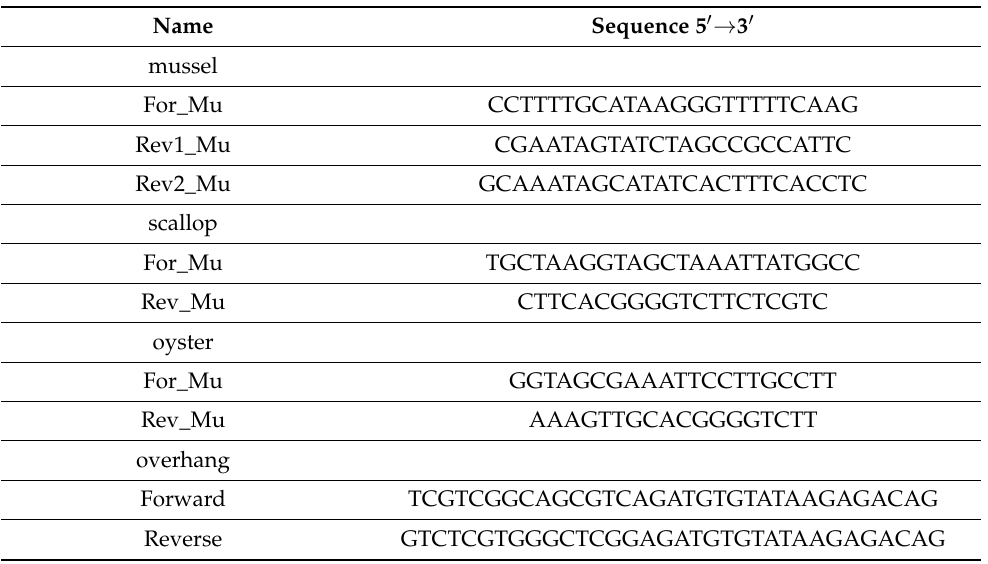
Table 2. Primers designed in this